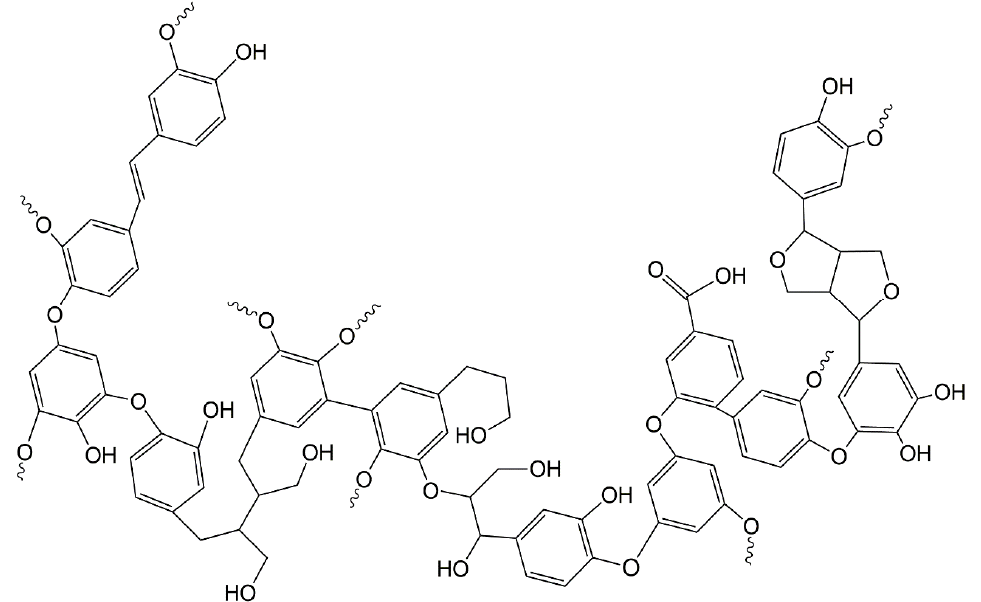
Figure 1. Lignin fragment hypothetical structure. Adapted from [22].